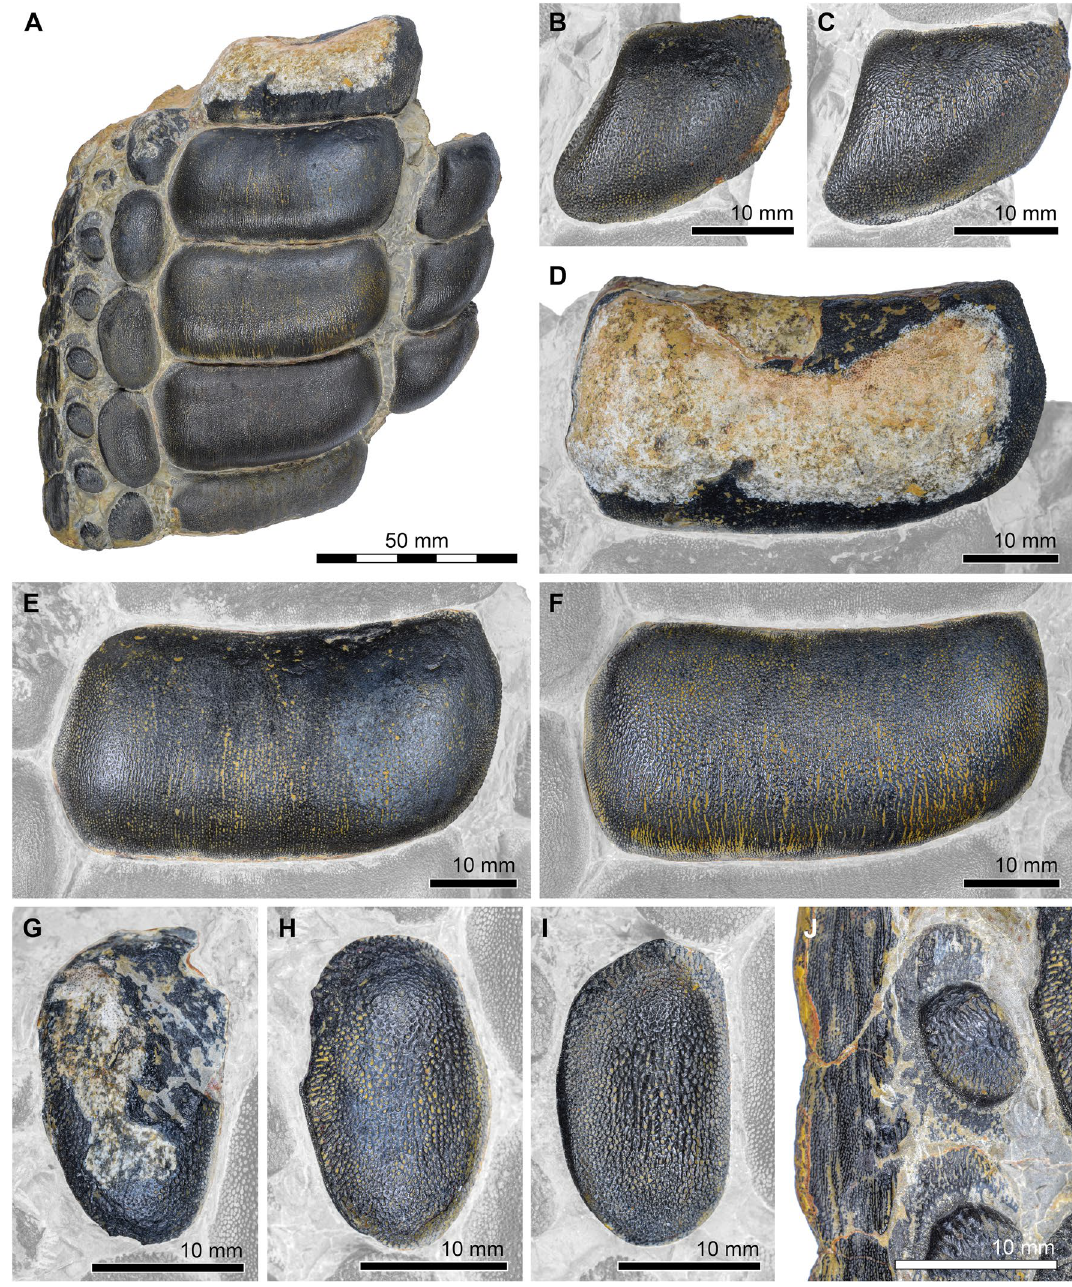
Fig. 3 Strophodus atlasensis sp. nov., PIMUZ A/I 5181, holotype, from the upper Agoudim Formation (Bajocian) near Talsint, Figuig Province, Morocco. Complete specimen ( A ) with close-up views of first lateral ( B , C ), second lateral ( D – F ) and first posterior teeth ( G – I ), plus close-up of second posterior tooth ( J